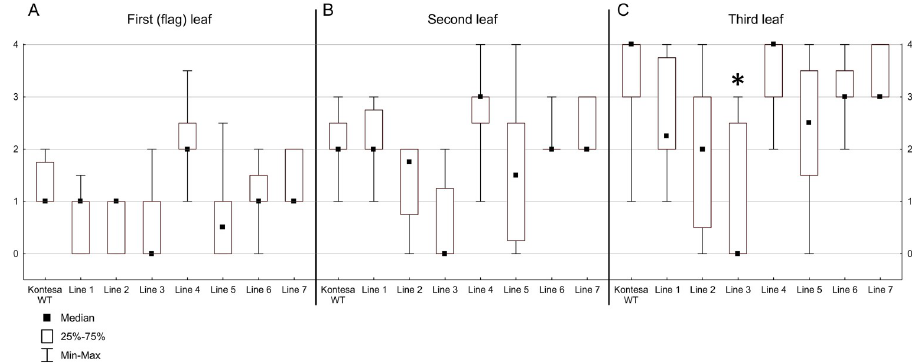
Fig 4. Infection types scored on the first (flag) leaf A, the second leaf B and on the third leaf C of nontransgenic Kontesa and 7 transgenic lines overexpressing TaWAK6 gene inoculated with P . triticina single spore isolate.